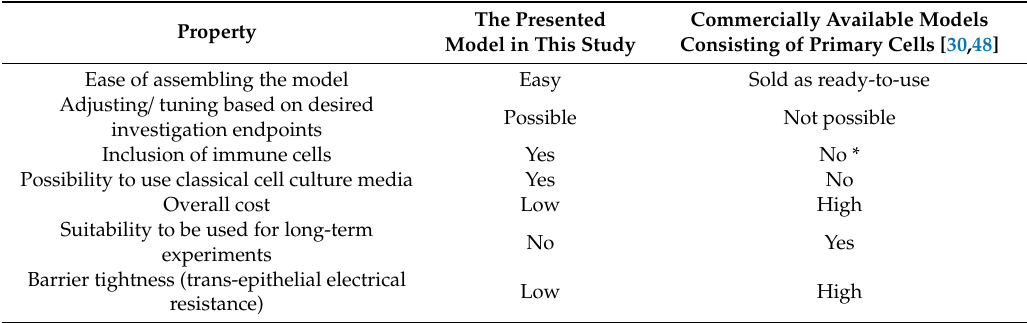
Table 2. The comparison of the 3D lung co-culture model presented in this study to commercially available 3D lung co-culture models consisting of primary cells. The Presented Commercially Available Models Property Model in This Study Consisting of Primary Cells